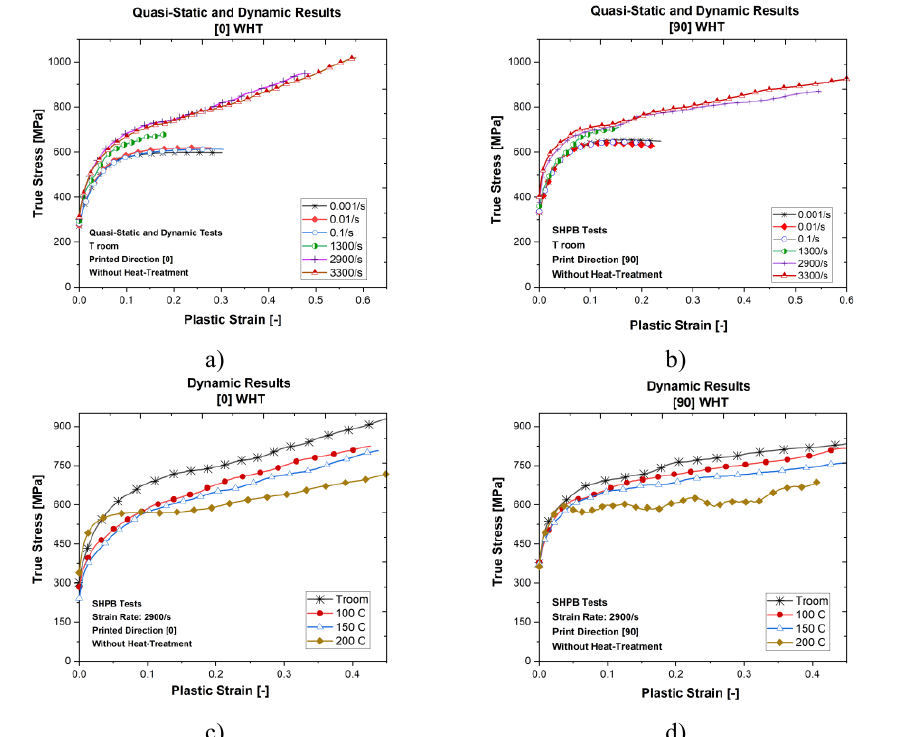
Fig. 1 . The experimental material test results describing the horizontally and vertically printed samples at different strain rates (a, b) and at different temperatures (c,